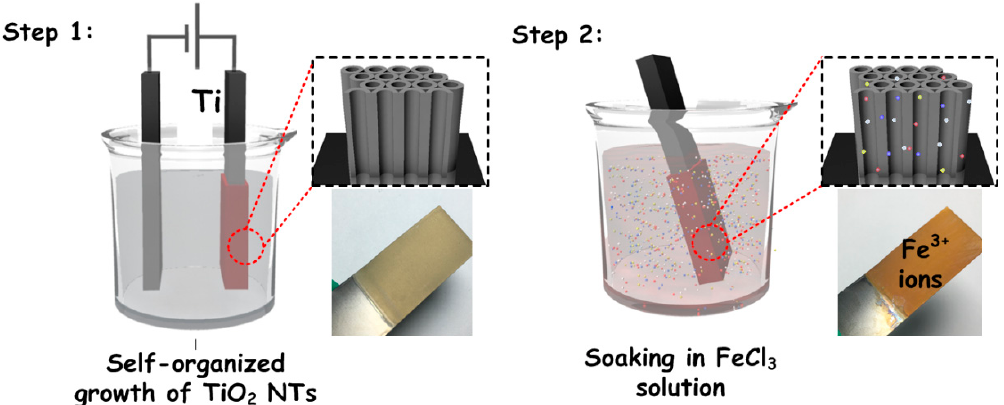
Figure 1. Schematic synthesis diagram of the amorphous TiO 2 and Fe 3 + -doped TiO 2 nanotubes arrays (NTAs), involved the photographs of one sample.